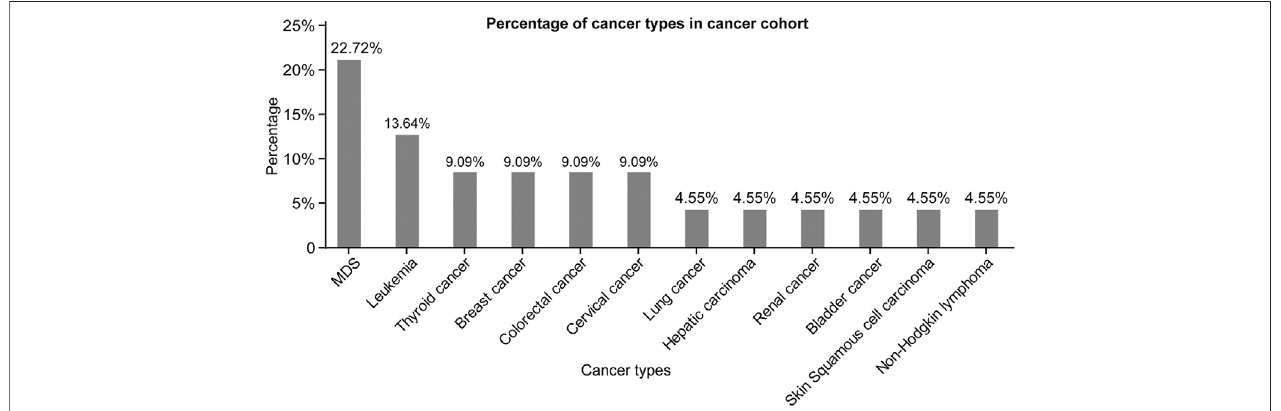
FIGURE 2 | Percentage of cancer types in cancer cohort. Abbreviations: MDS, myelodysplastic syndrome.